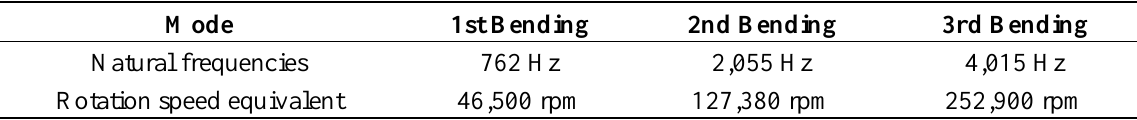
Table 3. Natural frequencies of circular shaft using